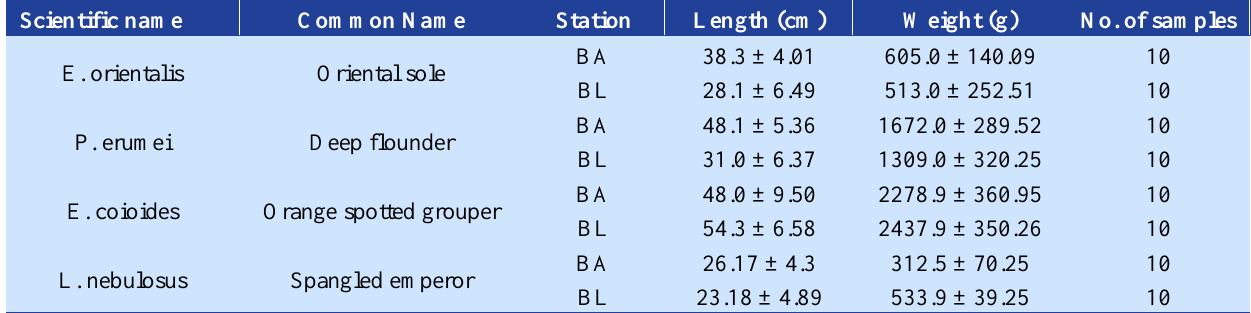
Table 1. Overview of sampled species